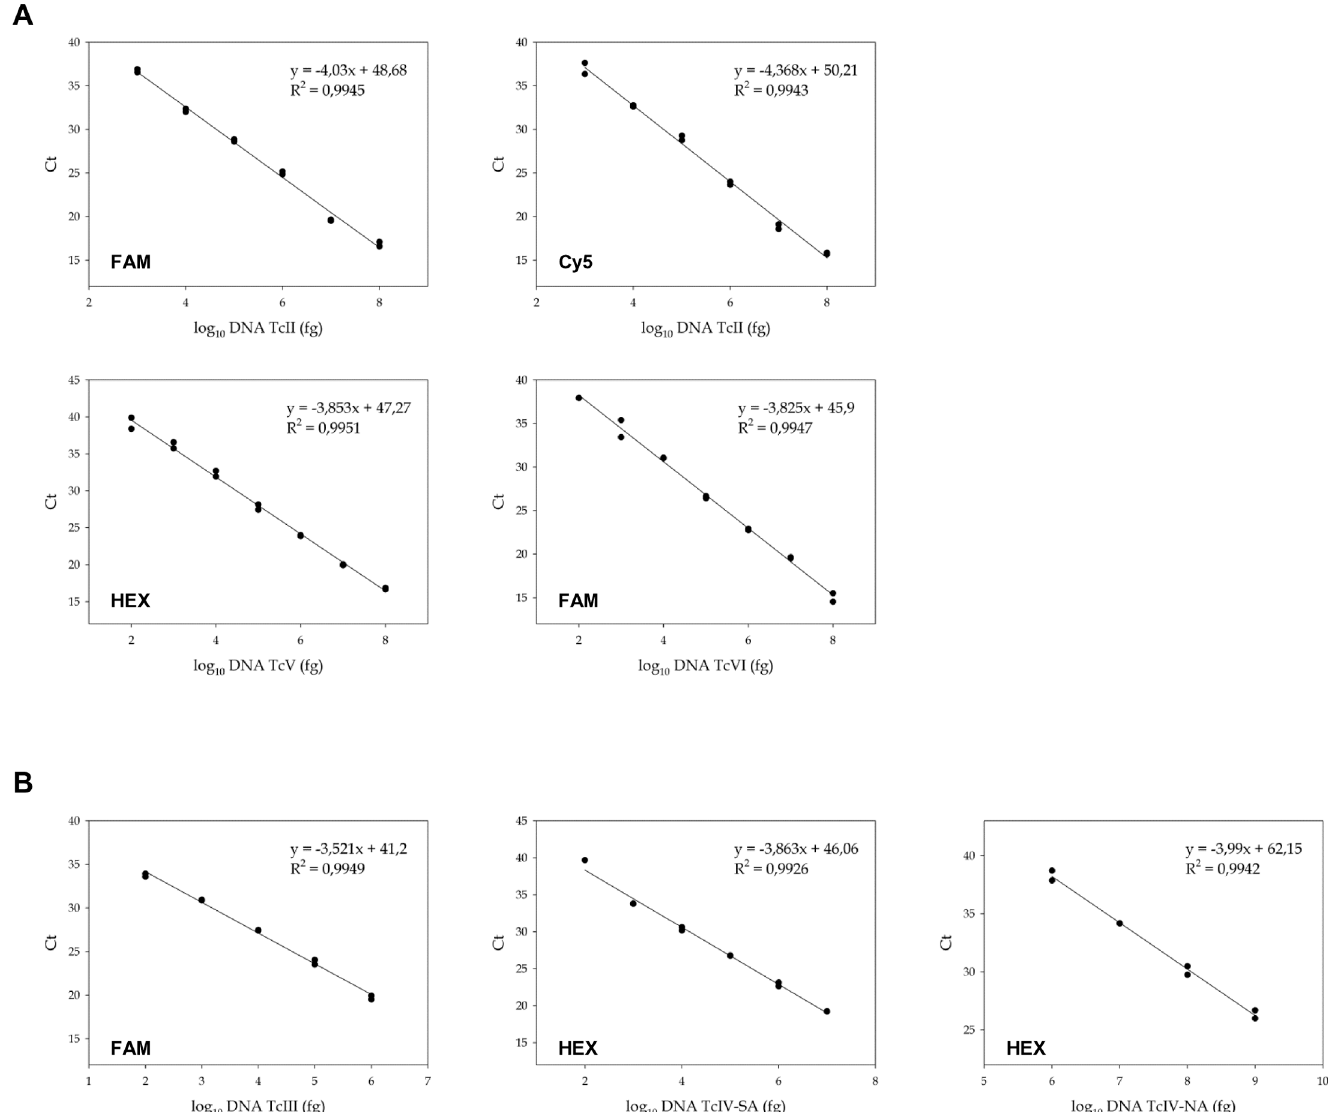
Fig 3. Linear range and analytical sensitivity of the second round multiplex real-time PCR tests. A. 18S-COII MTq PCR assay for reference stocks representing T . cruzi DTUs TcII, TcV and TcVI. Detection of TcII stock is shown for both TaqMan probes 18S-FAM and COII-Cy5. B. 24S α MTq PCR